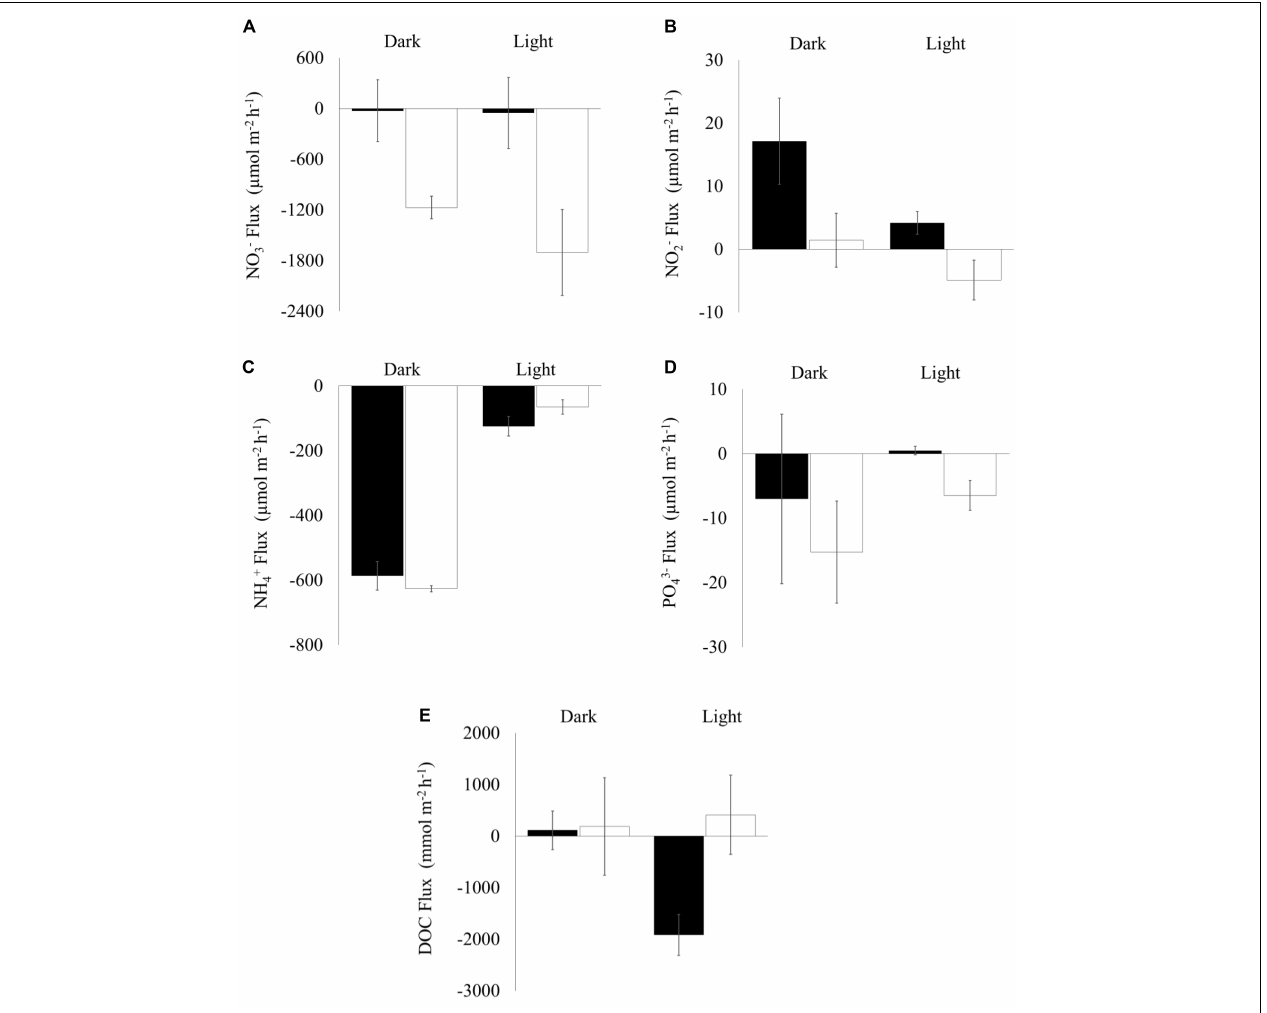
FIGURE 4 | Sediment-water nutrient fluxes (Mean ± SE, n = 10) during light and dark incubations in cores collected from shorebird presence (filled bars) and absence (unfilled bars) plots on day 45 (06 March 2017). X-axis marks zero flux, positive values show flux out of the sediment, negative values show flux into